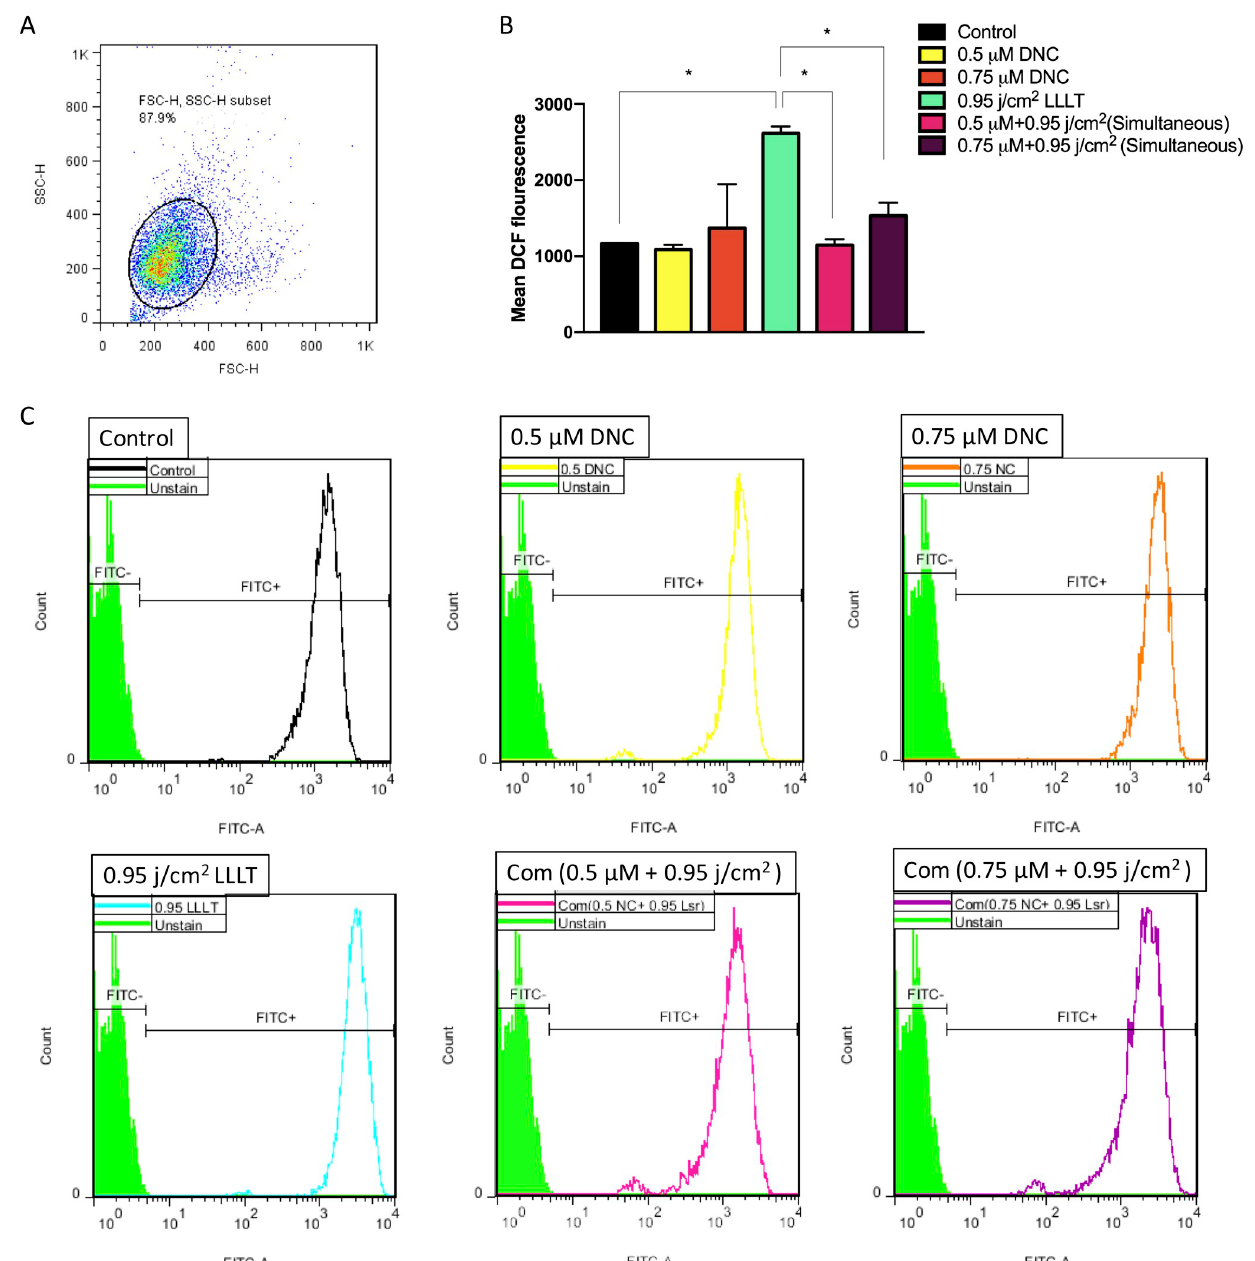
Fig 8. Flow cytometry analysis of intracellular ROS generation in MEFs under 48h treatment with DNC, LLLT (450 nm) and in combination. (A) Graph represents the cell population under the study using FITC-A versus SSC-A plot. (B) Bar Graphs showing the difference in DCF fluorescent intensity in MEFs, each bar demonstrates the mean ± SEM, n = 3 ( � p < 0.05). (C) Histograms represent changes in the intensity of DCF fluorescence, arising from production and accumulation of intracellular ROS in